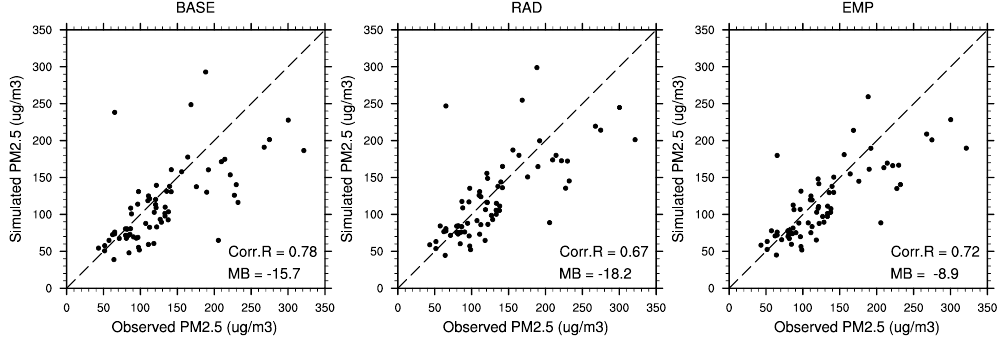
Figure 5. Scatter plots of monthly mean PM 2 . 5 mass concentrations in 71 cities in January 2013.